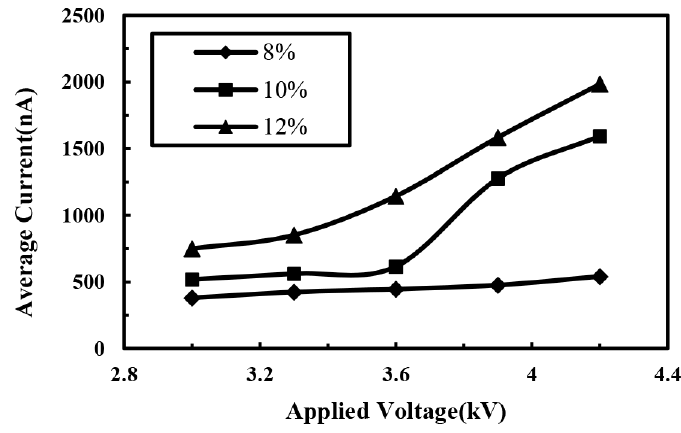
Figure 8. Relationship between average electrohydrodynamic direct-written current and applied voltage under different solution concentrations. The distance between spinneret and collector and the solution supply rate were 6 mm and 100 μL/h, respectively.